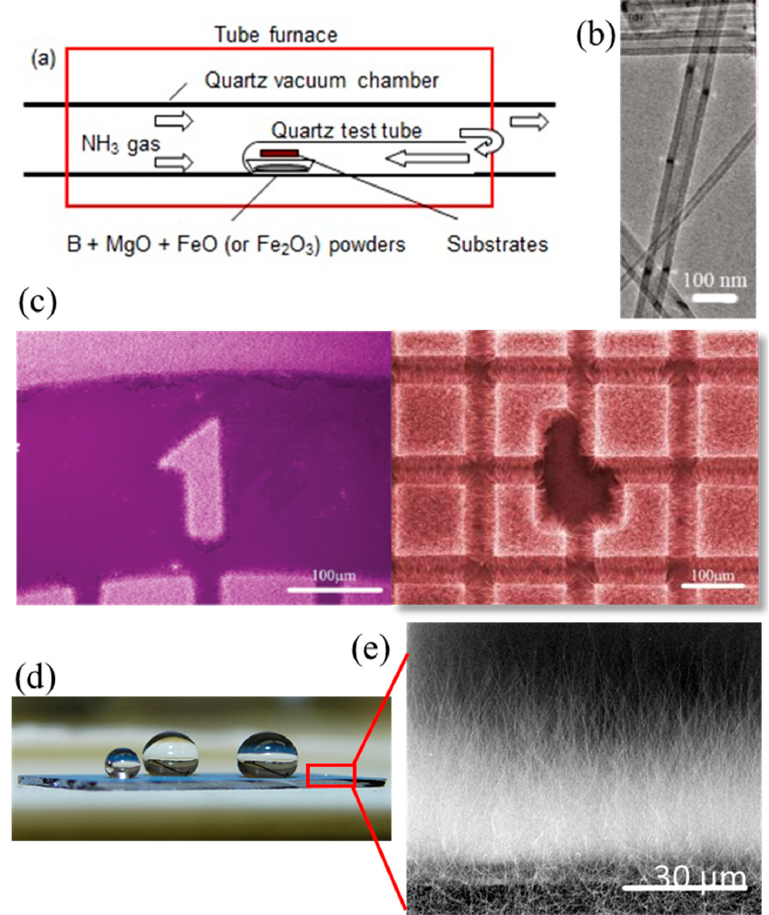
Figure 1. ( a ) Experimental setup for the growth of BNNTs in a horizontal tube furnace. Adapted with permission from [30]. Copyright 2008 IOP Publishing Ltd.; ( b ) TEM image showing tubular structure of BNNT with amorphous free side walls; ( c ) Well-defined patterned growth of BNNTs on a substrate. Adapted with permission from [4]. Copyright 2010 American Chemical Society; ( d ) Photograph of water droplet on the surface of BNNT film produced by CCVD showing superhydrophobicity; ( e ) Zoom-in cross sectional view of BNNTs on Silicon substrate showing that these BNNTs are grown vertically aligned on the substrate surface. Adapted with permission from [8]. Copyright 2012